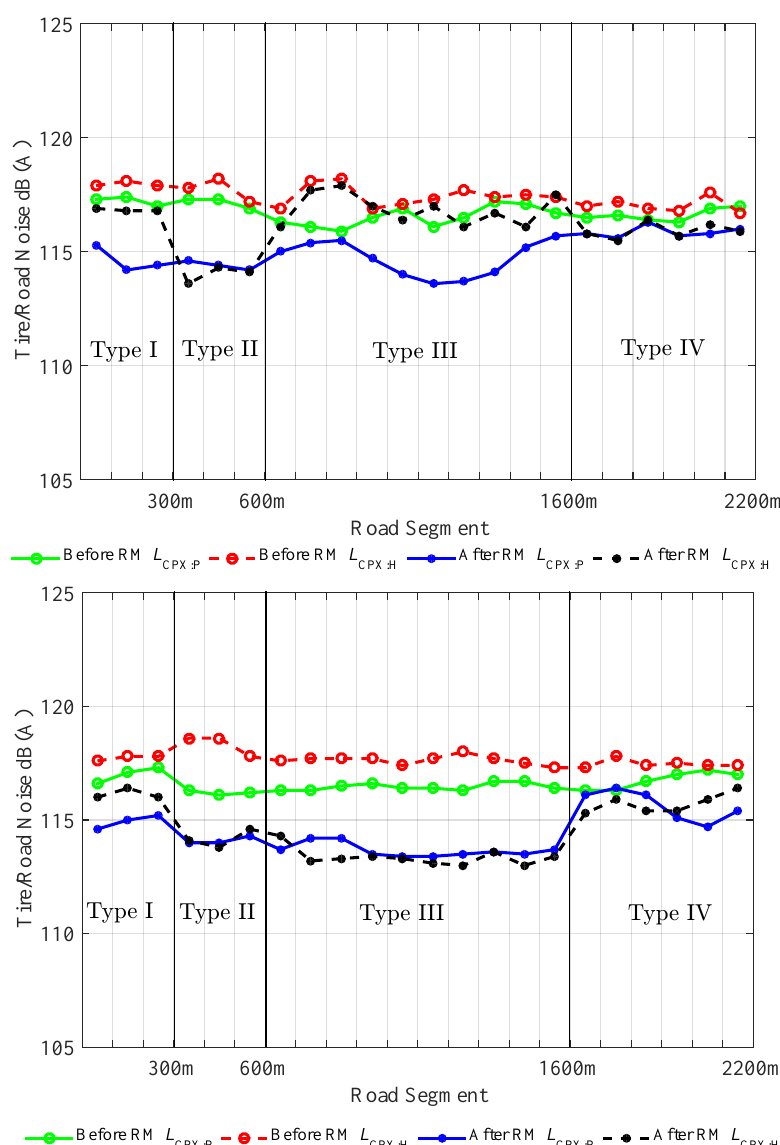
Figure 6. Tire/road noise equivalent sound pressure level at 80 km/h before and after road mainte- nance (RM): inner lane ( Upper ); outer lane ( Lower